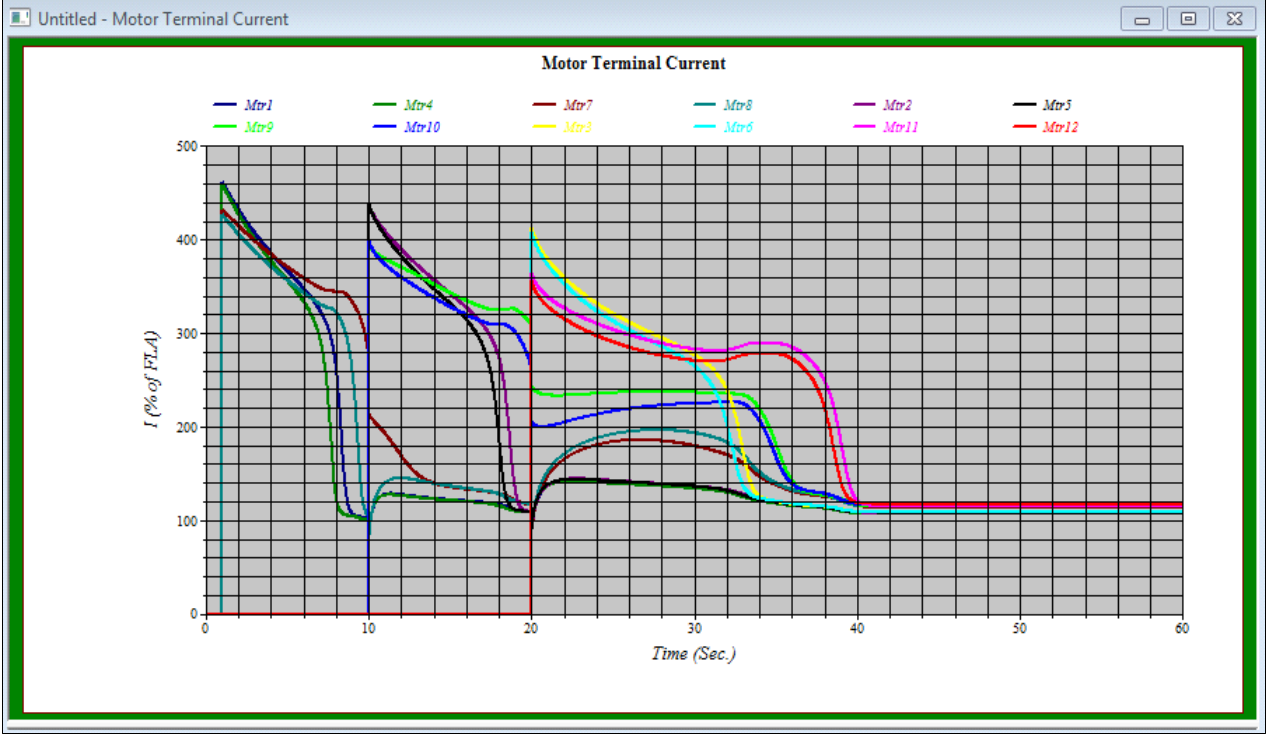
Figure 18: The starting current after the shift of start